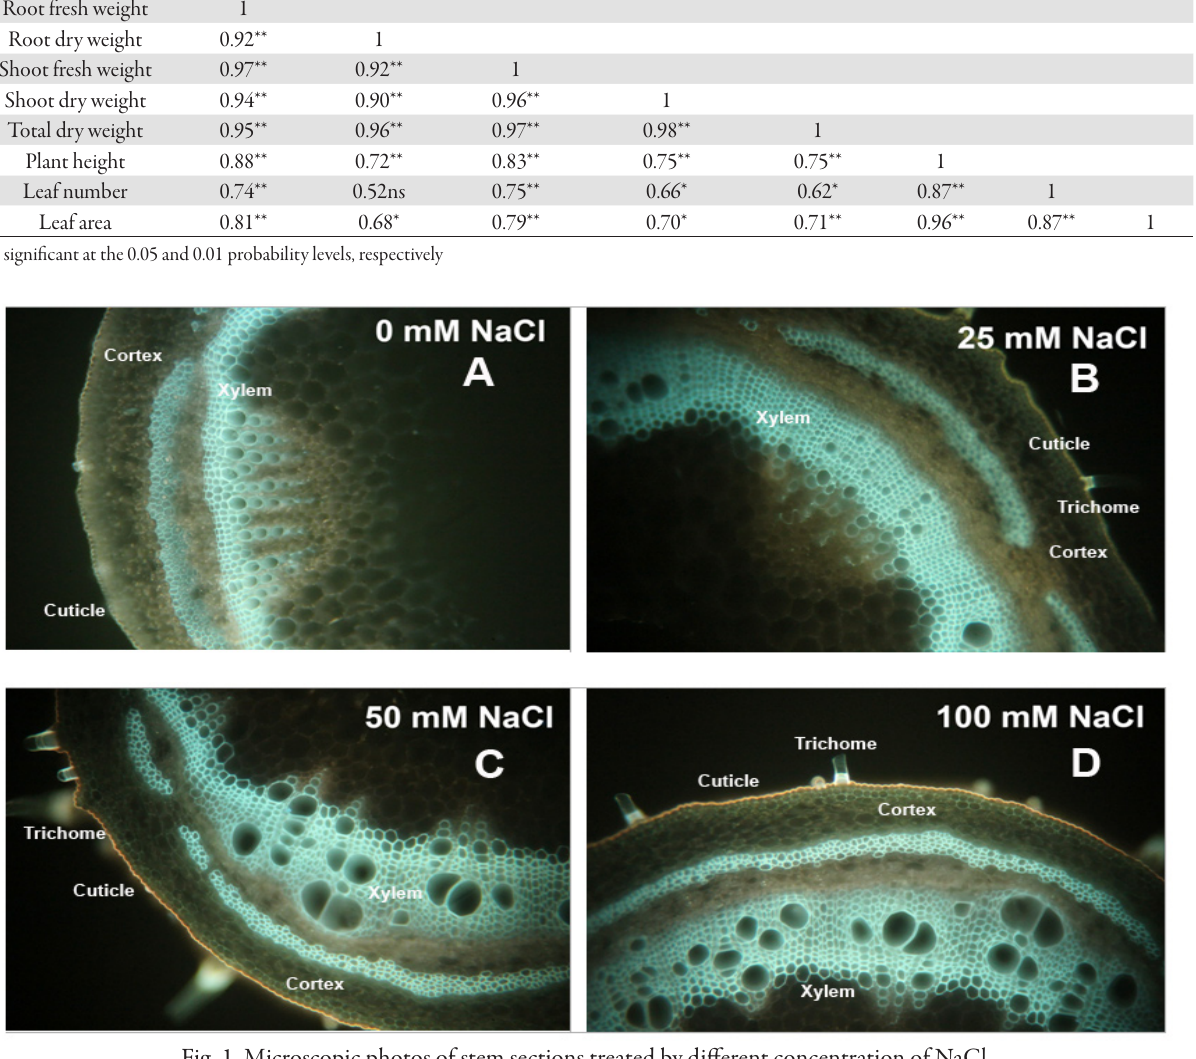
Fig. 1. Microscopic photos of stem sections treated by different concentration of